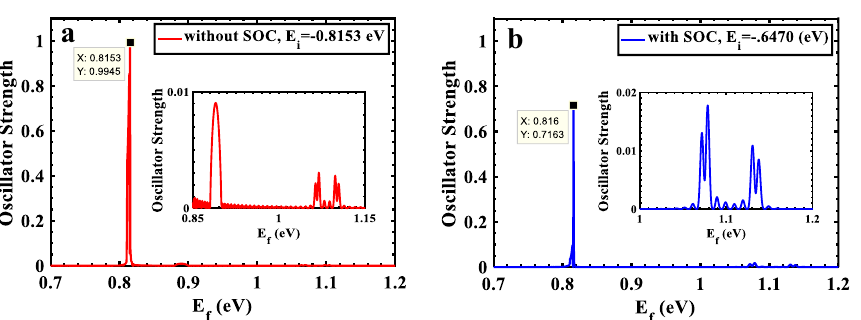
Figure 3. Behavior of oscillator strength for TMDC-PSL vs. different final states ( a ) without SOC and E i 0.8153 eV and ( b ) with SOC and E i = −